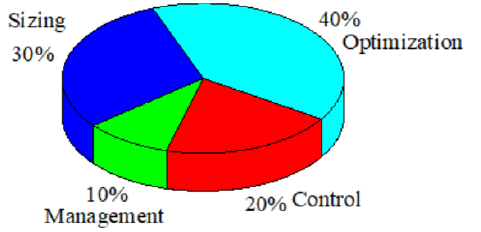
Figure 2. Number of Publications for HRES (1992 to 2022) depending on various configurations.